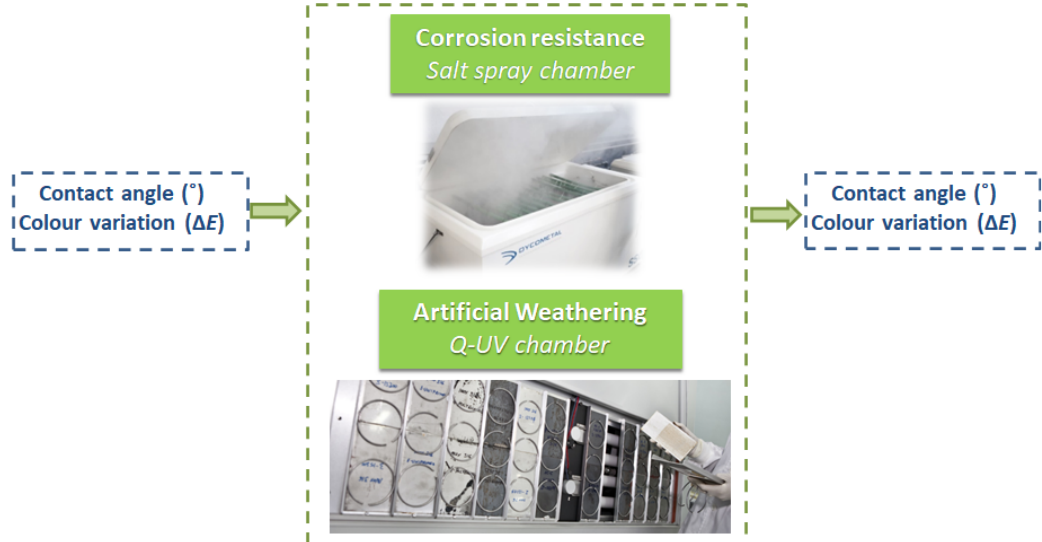
Figure 4. Environmental degradation tests conducted to evaluate the durability of coatings.